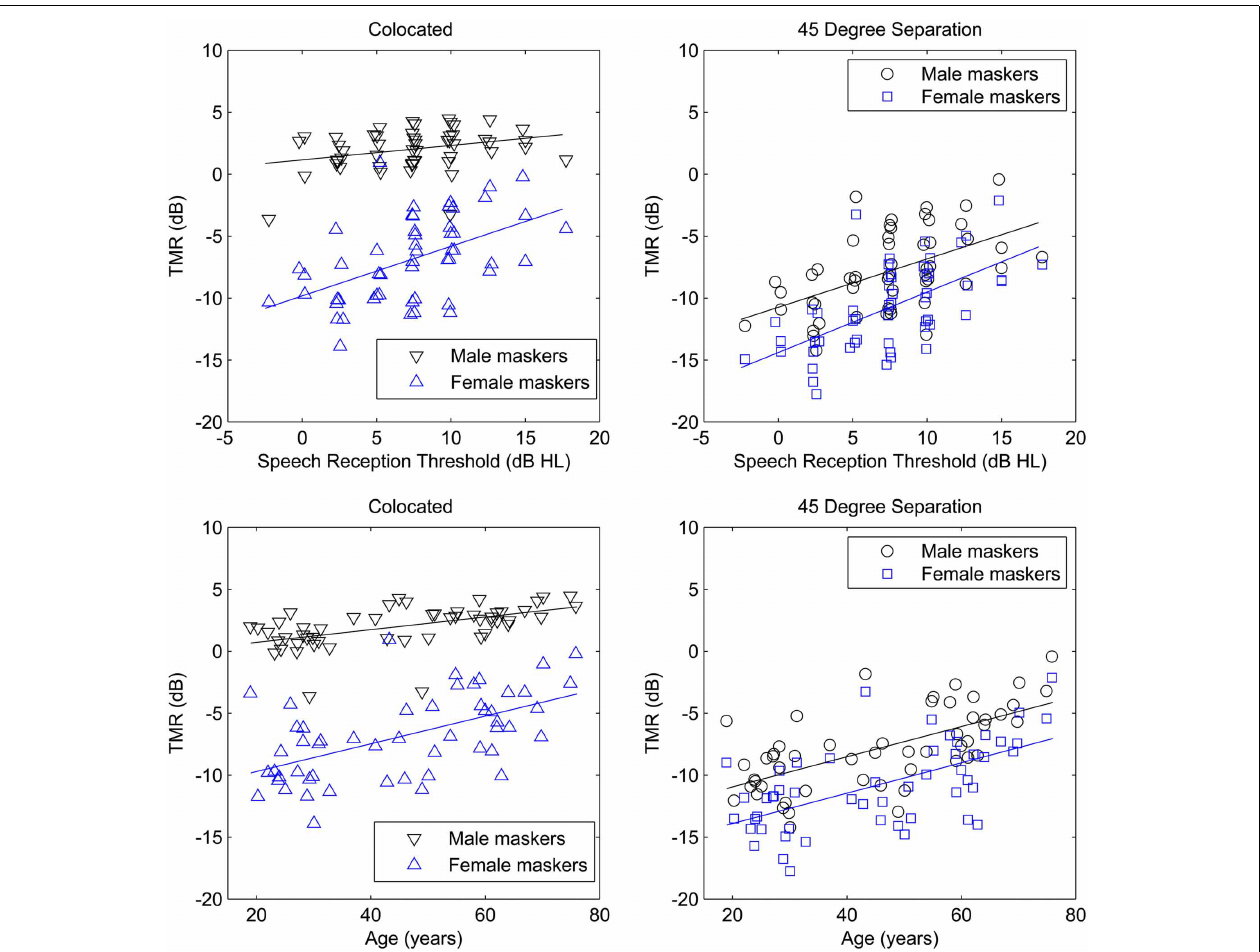
FIGURE 4 | TMR as a function of speech reception threshold (SRT; top panels) and age (bottom panels) for the participants in Experiment Two. Thresholds for male and female maskers are plotted